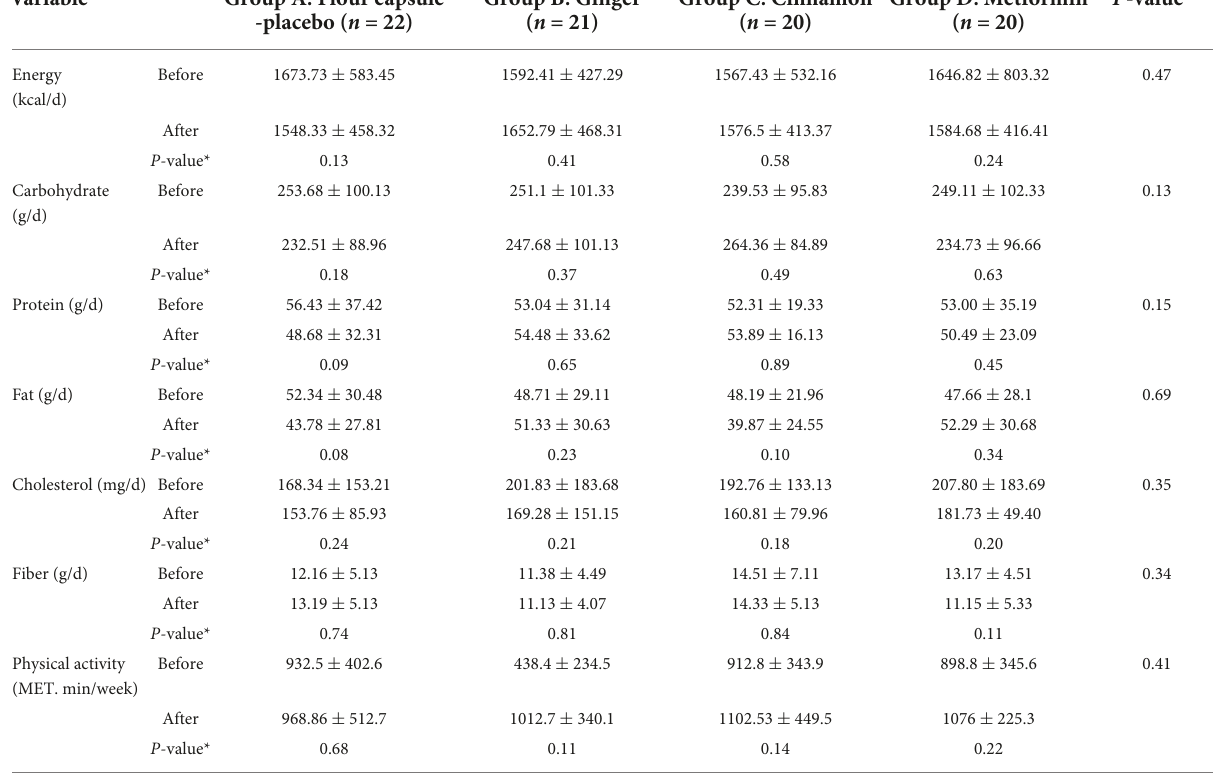
TABLE 2 Macronutrients, energy, cholesterol and fiber intake and physical activity level before and after intervention.